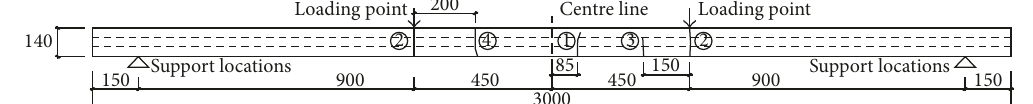
Figure 32: Failure mode of CB-3.